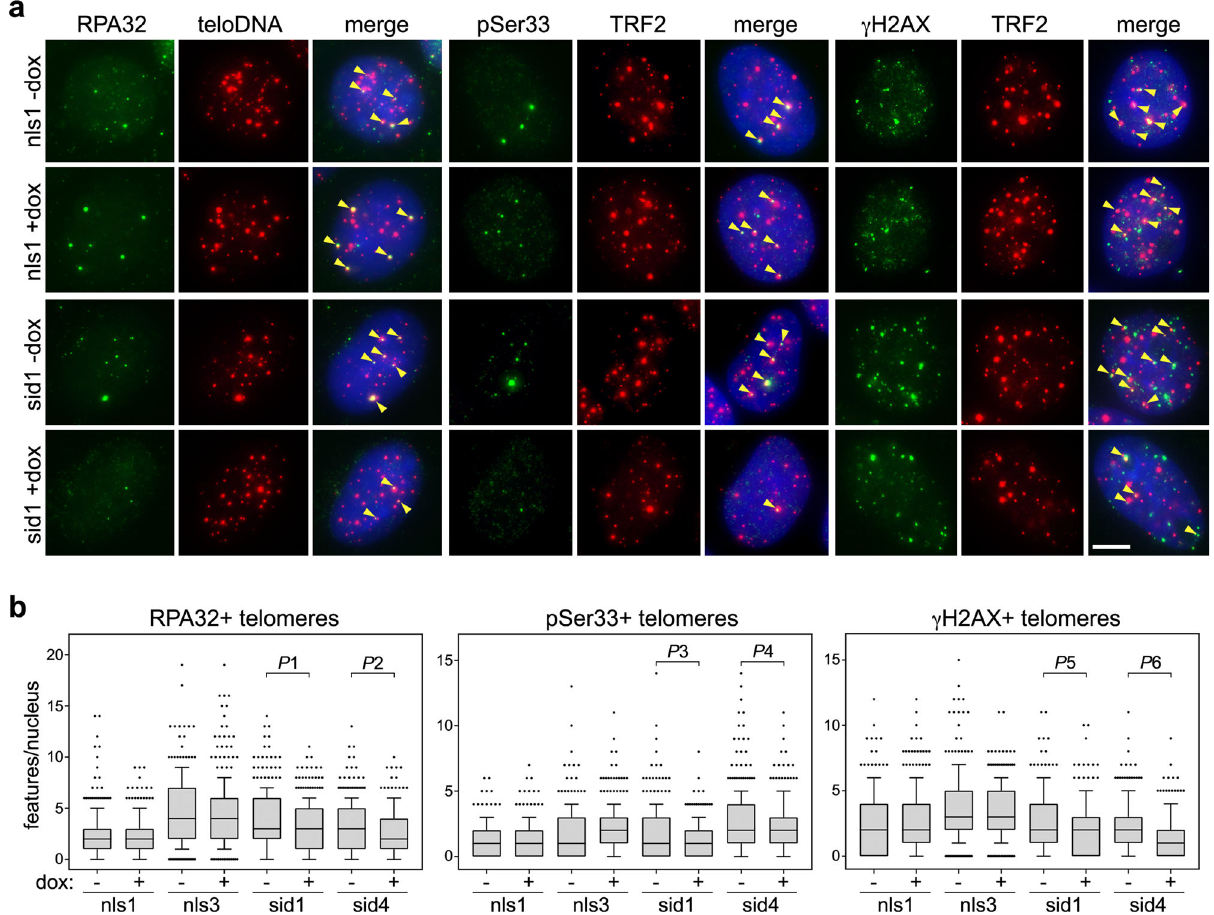
Fig. 2 TERRA transcription inhibition alleviates telomere instability. a Examples of RPA32, pSer33, or γ H2AX IF (green) combined with telomeric DNA FISH (teloDNA) or TRF2 IF (red). DAPI-stained DNA is in blue. The indicated cell lines were treated with dox for 24 h for RPA32 and pSer33 or 72 h for γ H2AX. Arrowheads in the merge panels point to co-localization events. Scale bar: 5 μ m. b Quanti fi cations of experiments as in a . Boxplots represent the medians (middle lines) and the fi rst and third quartiles (boxes), the whiskers extend to the 90th percentile of the values. A total of at least 300 nuclei from three independent experiments were analyzed for each sample. P- values were calculated with a two-tailed Mann – Whitney U test. P 1 = 0.0008; P 2 = 0.0010; P 3 = 0.0511; P 4 = 0.0080; P 5 < 0.0001; P 6 < 0.0001. Source data are provided as a Source Data fi